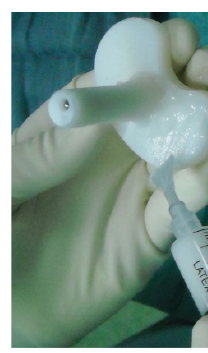
Figure 4. The hydrogel can be applied to modular parts, as shown here on the polyethylene tibial insert of a revision knee prosthesis, to provide a complete surface